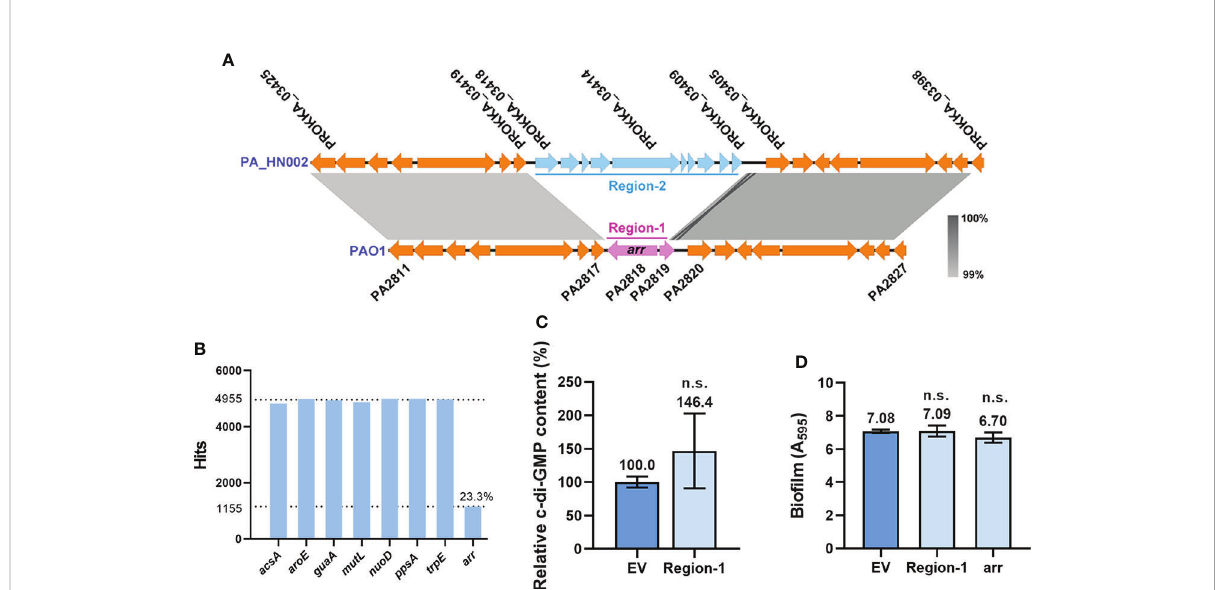
FIGURE 6 Loss of Arr did not affect intracellular c-di-GMP content and bio fi lm formation. (A) Replacement of the arr gene-containing region (Region-1) by a fragment containing 10 coding sequences (Region-2) was detected in the PA_HN002 genome. The light, gray-shaded regions showed more than 99% sequence identity. (B) Abundance of the arr gene in 4,955 P. aeruginosa genomes. A set of house-keeping genes acsA , aroE , guaA , mutL , nuoD , ppsA and trpE used for MLST analysis were selected as controls to show their distributions in almost 100% genomes. (C) Relative intracellular c-di-GMP content measured by LC-MS in the PA_HN002 strain complemented with the fragment of Region-1 from PAO1. (D) Bio fi lm formation of the PA_HN002 strain and PA_HN002 with the complementation of the Region-1 and overexpression of the arr gene. n.s., not signi fi cant based on Student ’ s t -test. EV, empty